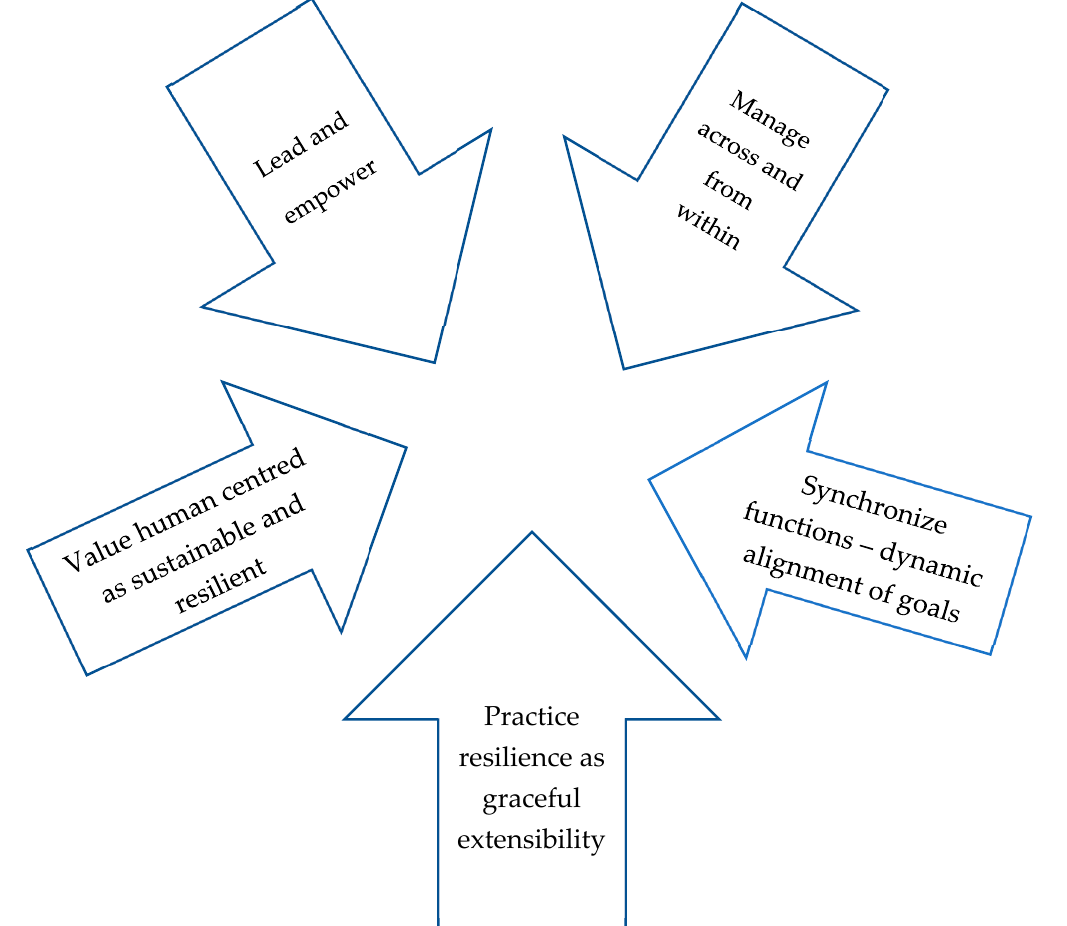
Figure 4. Summary of suggested key vectors that can support the endeavour of sustaining human- centred design and management of production and logistics systems for resilience (source: author).